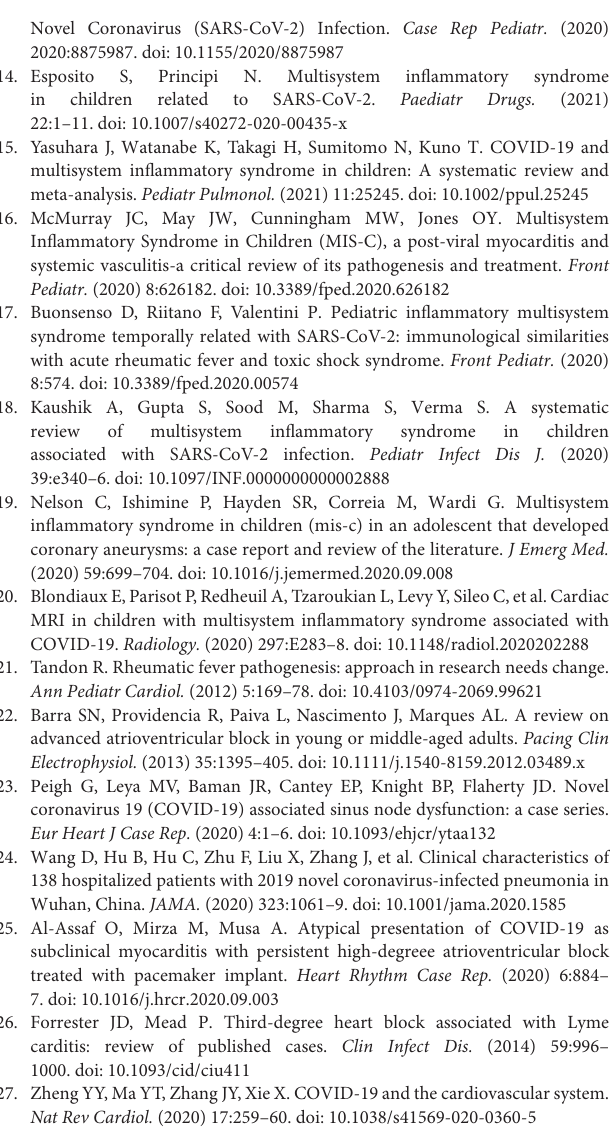
Supplementary Figure 1 | The cardiac magnetic resonance imaging performed about 40 days after the onset found no morpho-functional abnormalities with non-dilated ventricles, a normal systolic function and a mild pericardial effusion with a maximum thickness of 7